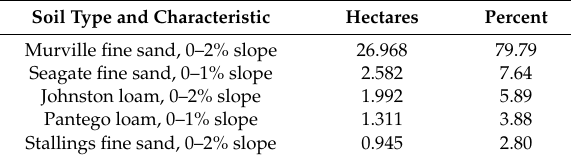
Table 2. Description, area (hectares) and percent of SSURGO soil units within Area of Interest